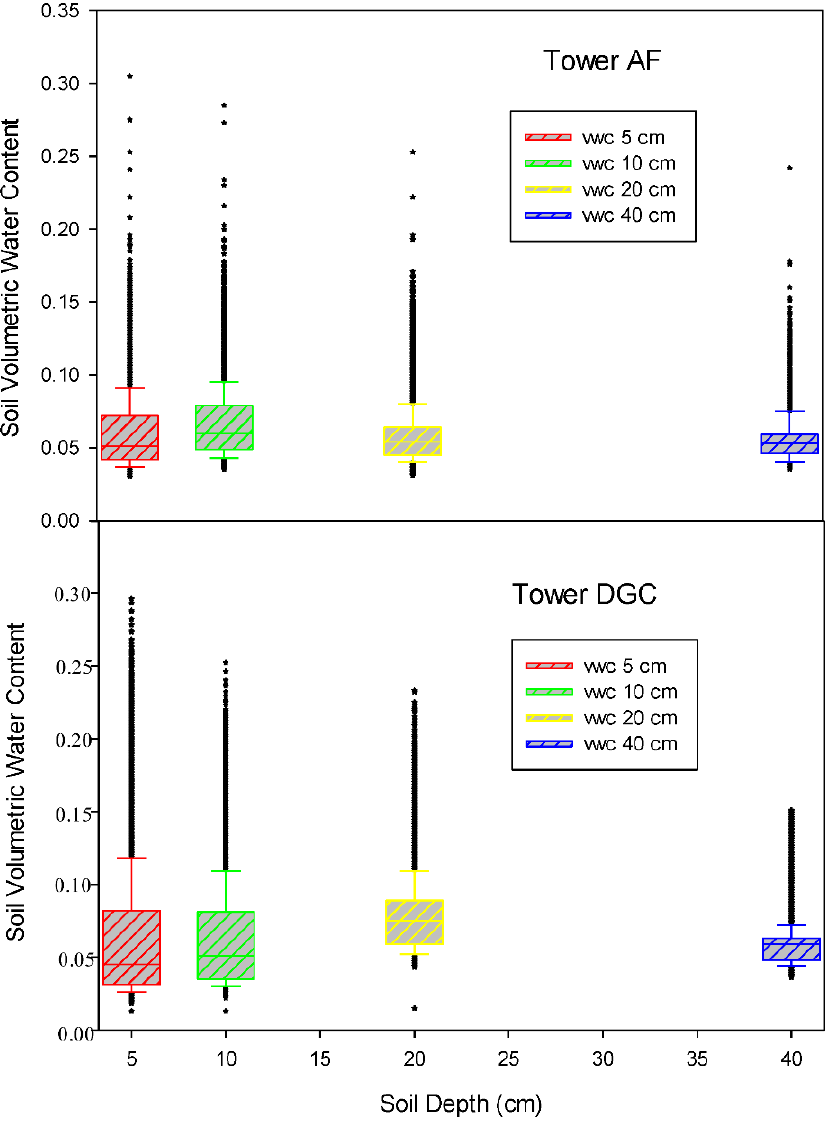
Figure 2. Boxplots of soil volumetric water content at the 5, 10, 20 and 40 cm depths for both the AF and DGC tower locations. The boxplots reveal the median value, upper and lower quartiles, minimum and maximum values and potential outliers. The median values revealed no significant differences in soil volumetric water content with depth or between sites.